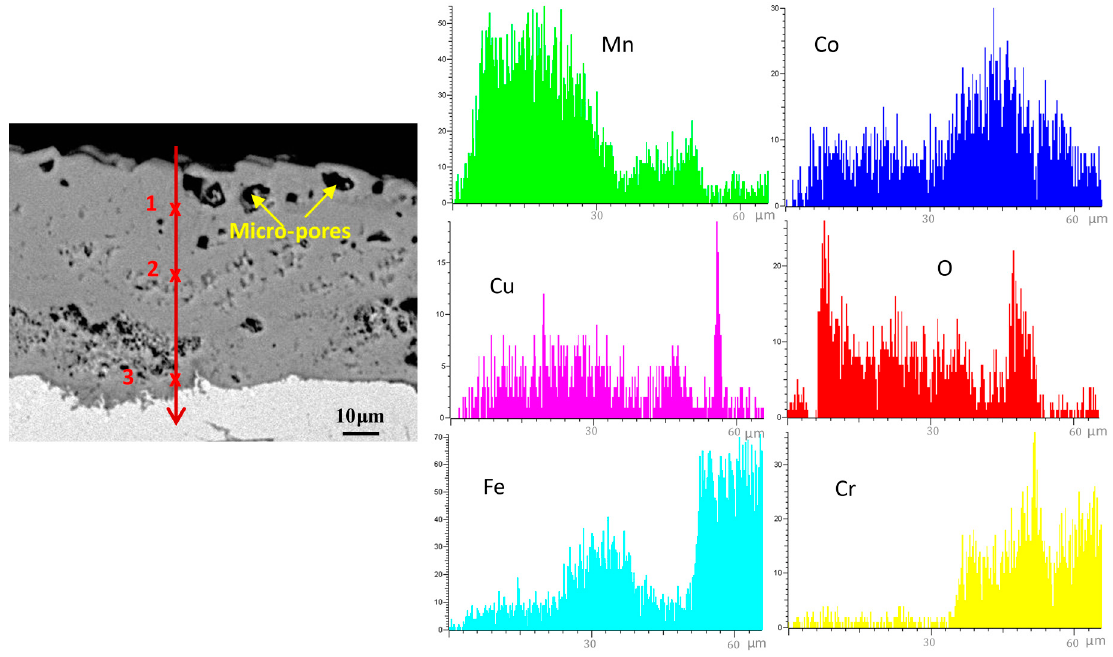
Figure 5. Cross-section morphology and EDS line scanning of Co-33Mn-17Cu coating oxidized at 750 °C in air for 100 h. The line scan position is shown in the cross-sectional image. Table 3. Composition analysis by EDS of the local region in Figure 5.